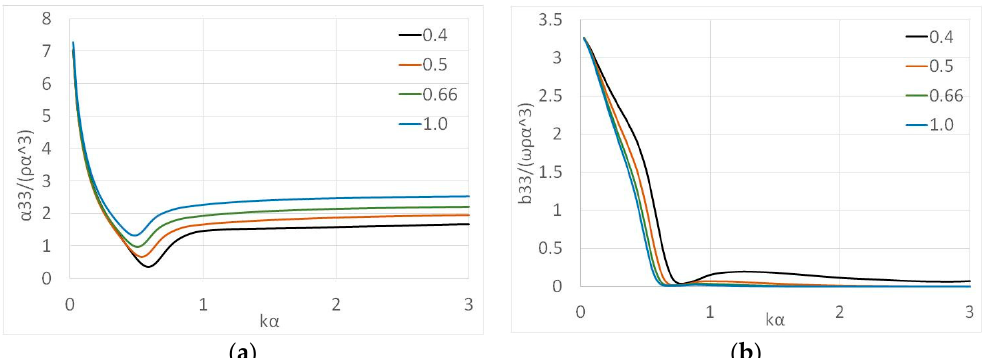
Figure 8. Hydrodynamic coefficients of a floating cylindrical floater placed in front of an orthogonally shaped (right angle) breakwater using the method of images for a /h = 0.4; 0.5; 0.66; 1.0: ( a ) heave added mass due to motion of the floater in heave ( b ) heave damping due to motion of the floater in heave.